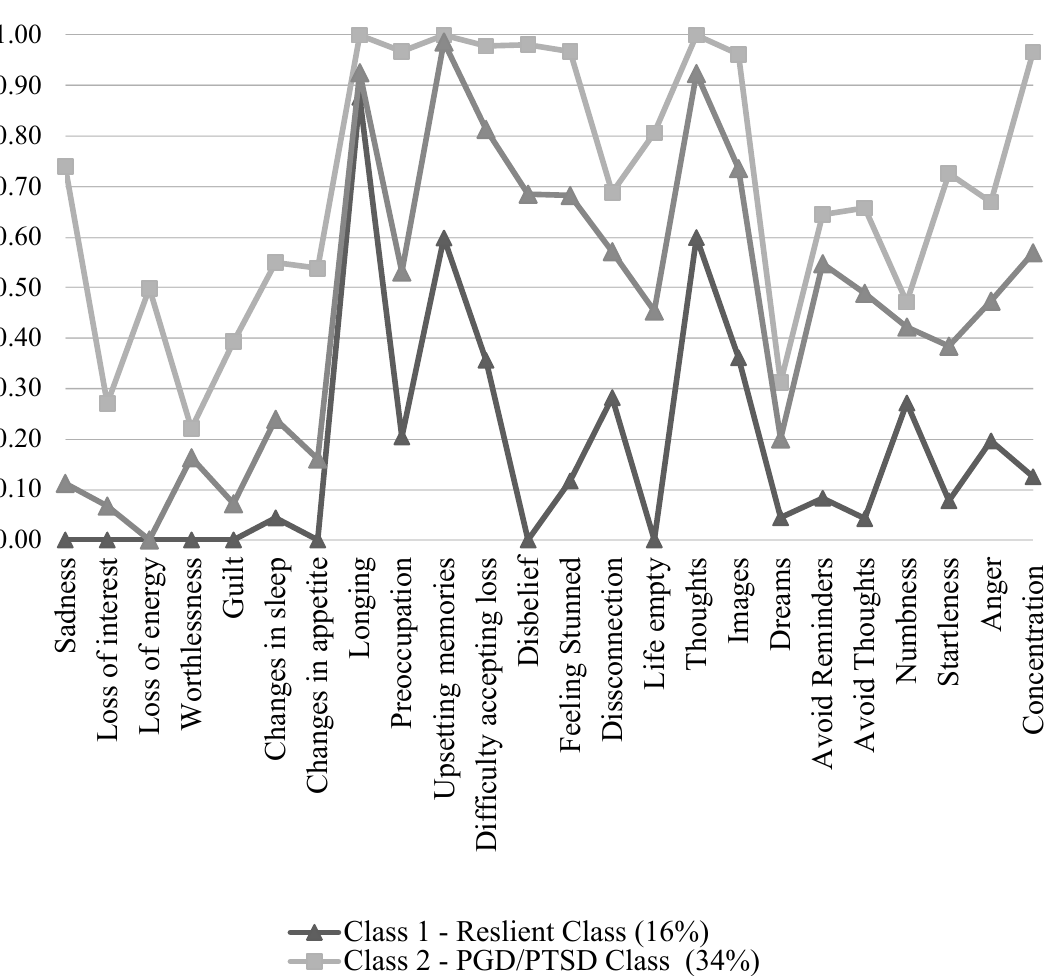
Figure 2. Estimated symptom endorsement profiles for the 3-class model of the latent class analysis ( N = 159).